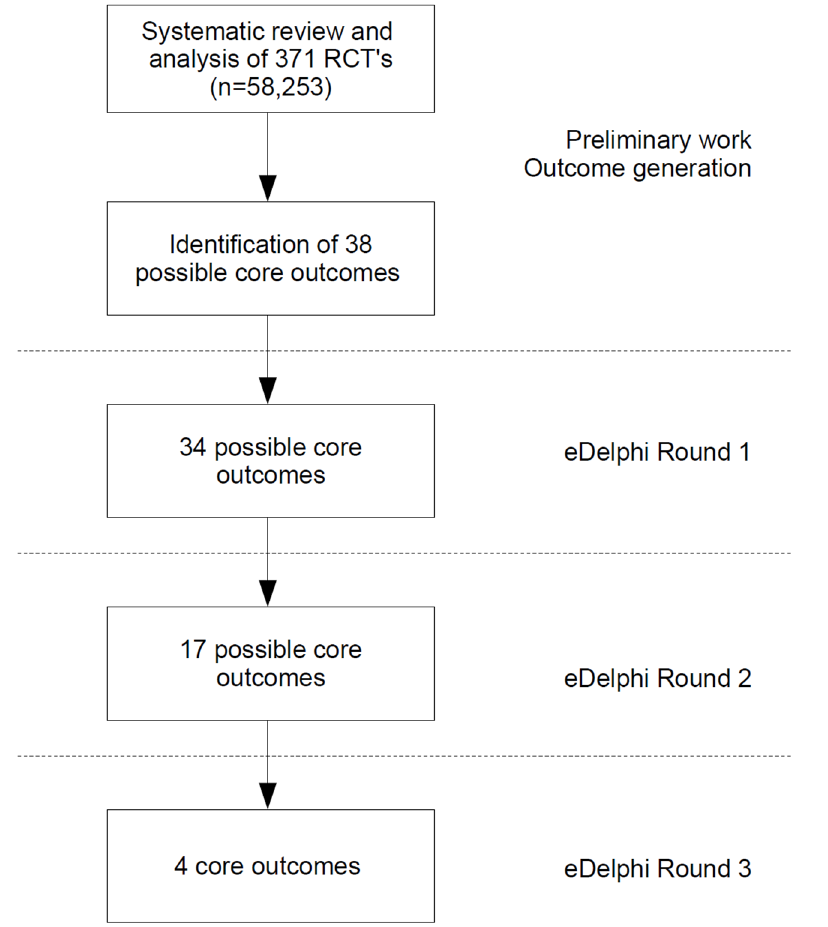
Fig 1. Flow diagram of eDelphi process and core outcome